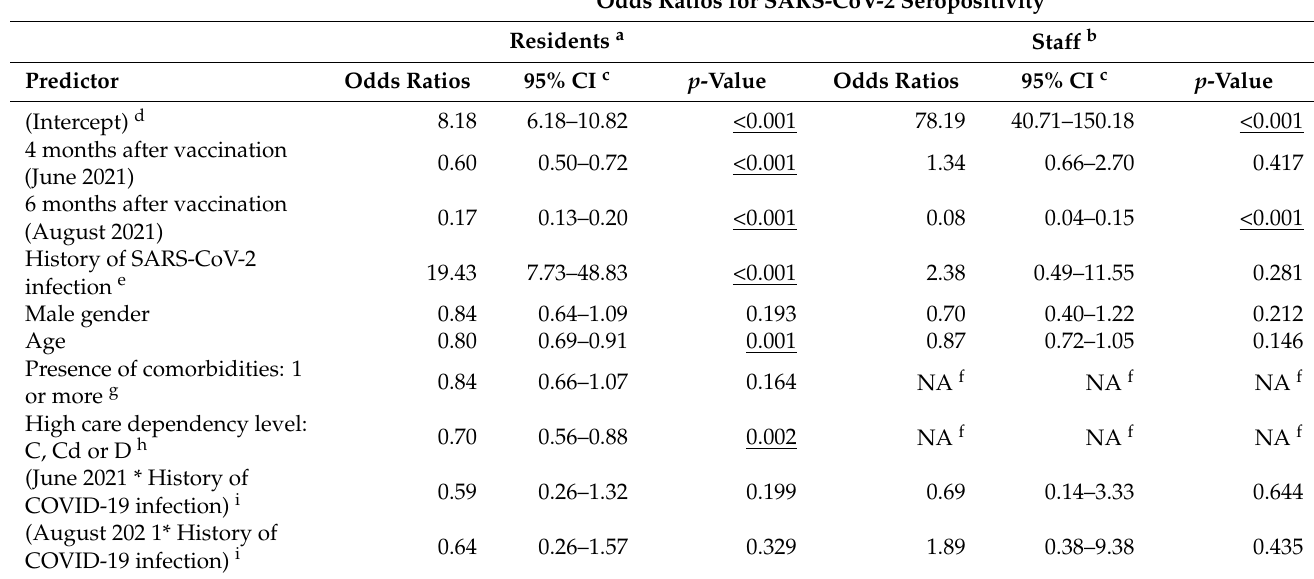
Table 2. Association between SARS-CoV-2 seropositivity and age, self-reported history of infection, sex, comorbidities, care dependency and time since